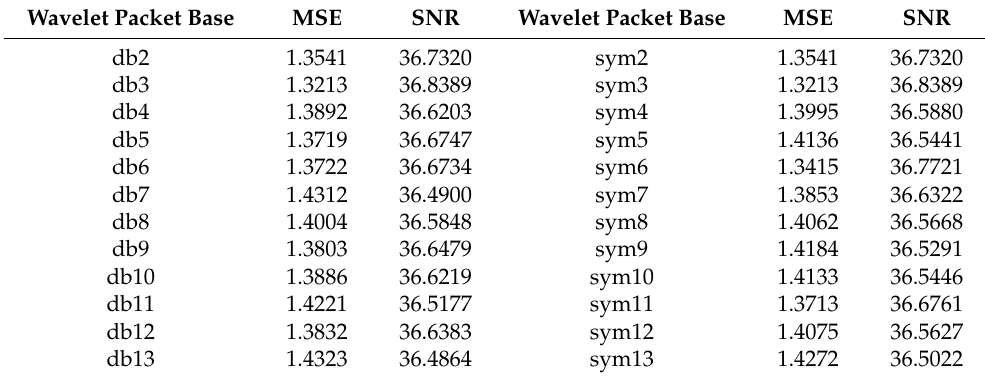
Table 2. The MSE and SNR of the db and sym wavelet packet base at different levels. Wavelet Packet Base MSE SNR Wavelet Packet Base